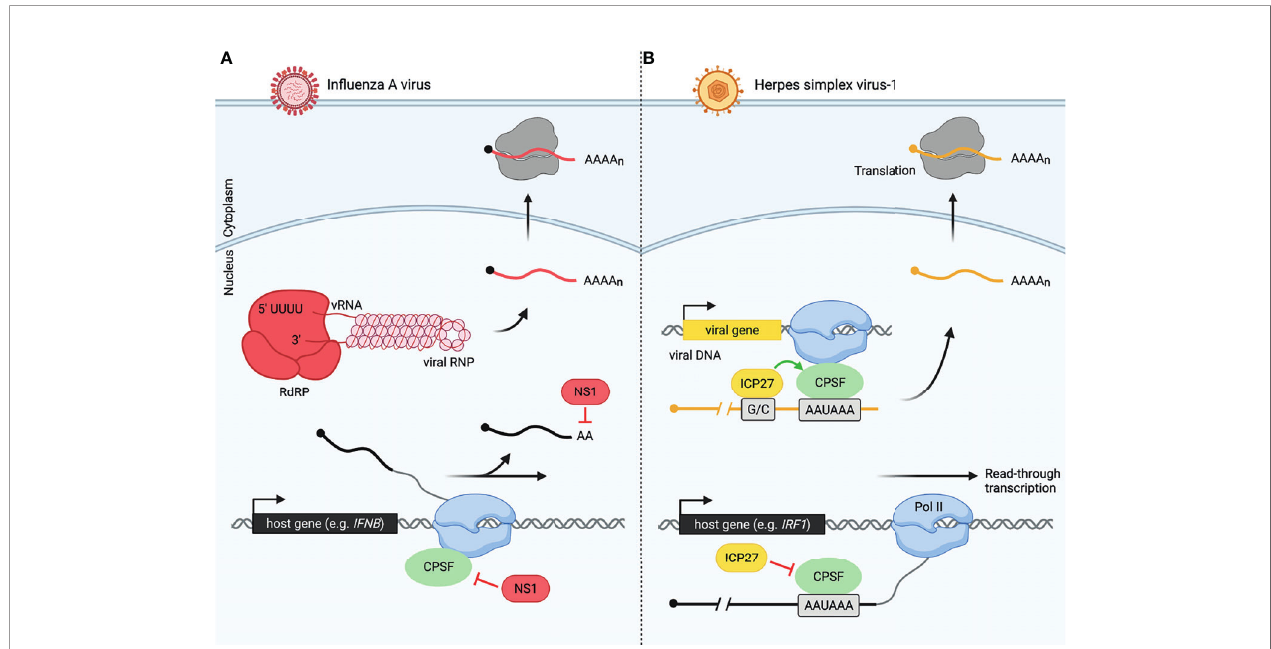
FIGURE 2 | Viruses have evolved distinct mechanisms to modulate host and viral 3´-end processing, allowing host-speci fi c disruption. (A) In fl uenza A virus (IAV) uses NS1 protein to disrupt cellular 3´-end processing and a distinct method for viral 3´-end processing. Inhibition of cleavage and polyadenylation by NS1 causes read-through transcription of many host genes including IFNB during in fl uenza infection. Meanwhile, in fl uenza produces an RNA-dependent RNA polymerase (RdRP), allowing it to transcribe and process viral RNA (vRNA, shown as part of the IAV viral ribonucleoprotein, vRNP). Viral mRNA is also polyadenylated by RdRP once the polymerase reaches a 5´-U track on the vRNA. These viral mRNAs are then exported to the cytoplasm for translation by host ribosomes. In fl uenza viral RNA and proteins are colored in red, and host RNA is colored in black. (B) Herpes simplex virus-1 (HSV-1) uses ICP27 protein to disrupt cellular 3´-end processing and promote viral 3´-end processing. CPSF is unable to assemble correctly in the presence of ICP27. This leads to read-through transcript production from thousands of host genes including IRF1 in HSV-1-infected cells. HSV-1 uses the host machinery, RNA polymerase II (Pol II) and CPSF, for viral transcription and 3´-end processing, respectively. However, a GC-rich sequence (G/C) preceding the viral PAS is recognized by ICP27, allowing ef fi cient viral pre-mRNA cleavage by CPSF. Herpes viral RNA and proteins are colored in yellow, and host RNA is colored in